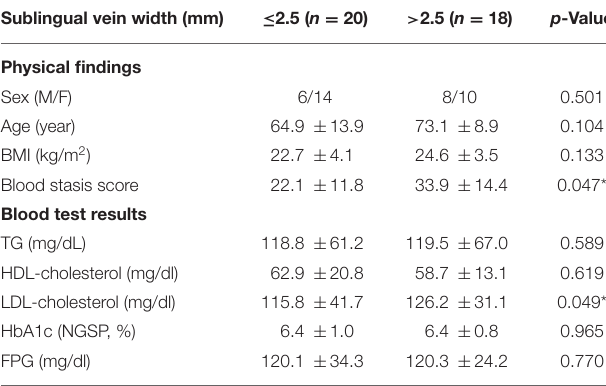
TABLE 1 | Diagnostic criteria for blood stasis. TABLE 2 | Characteristics of